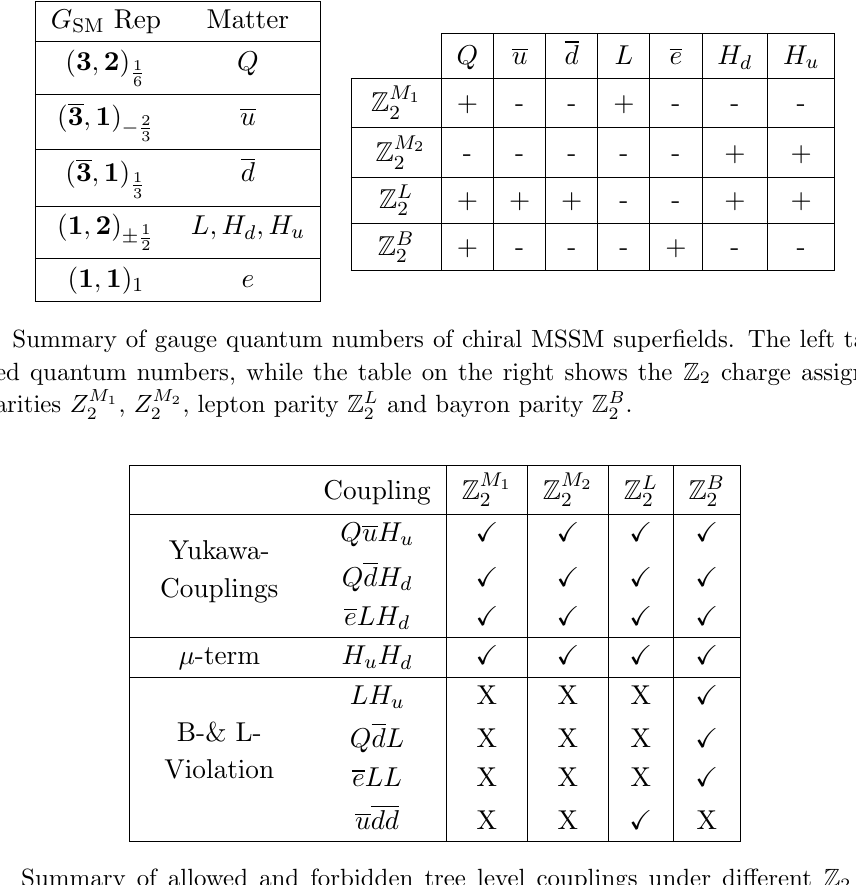
Table 2 . Summary of allowed and forbidden tree level couplings under di(cid:11)erent Z 2 symmetry charge assignments. While the (cid:12)rst four terms are required to be present the later four should better be